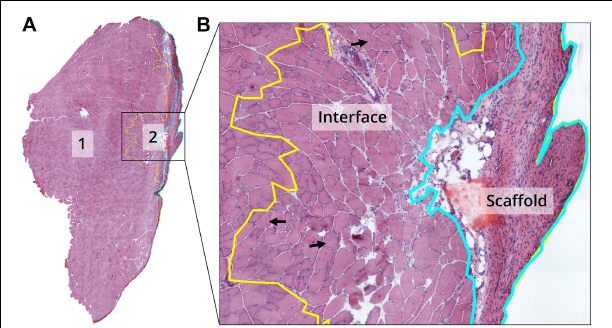
FIGURE 1 | Example of TA muscle cross-section and visual explanation of the different areas used for the quantifications. (A) Example picture of the hematoxylin–eosin (HE) staining of the entire TA muscle ( × 20 magnification), where we identified and manually traced the remaining native tissue (1) and the injury area (2). (B) Visual explanation of the division of the injury area into two clearly differentiated regions: interface (showing newly formed myofibers with central nuclei, highlighted with black arrows) and scaffold (no visible myofibers are present). Therefore, both the scaffold and interface areas conform the potentially injured/wounded